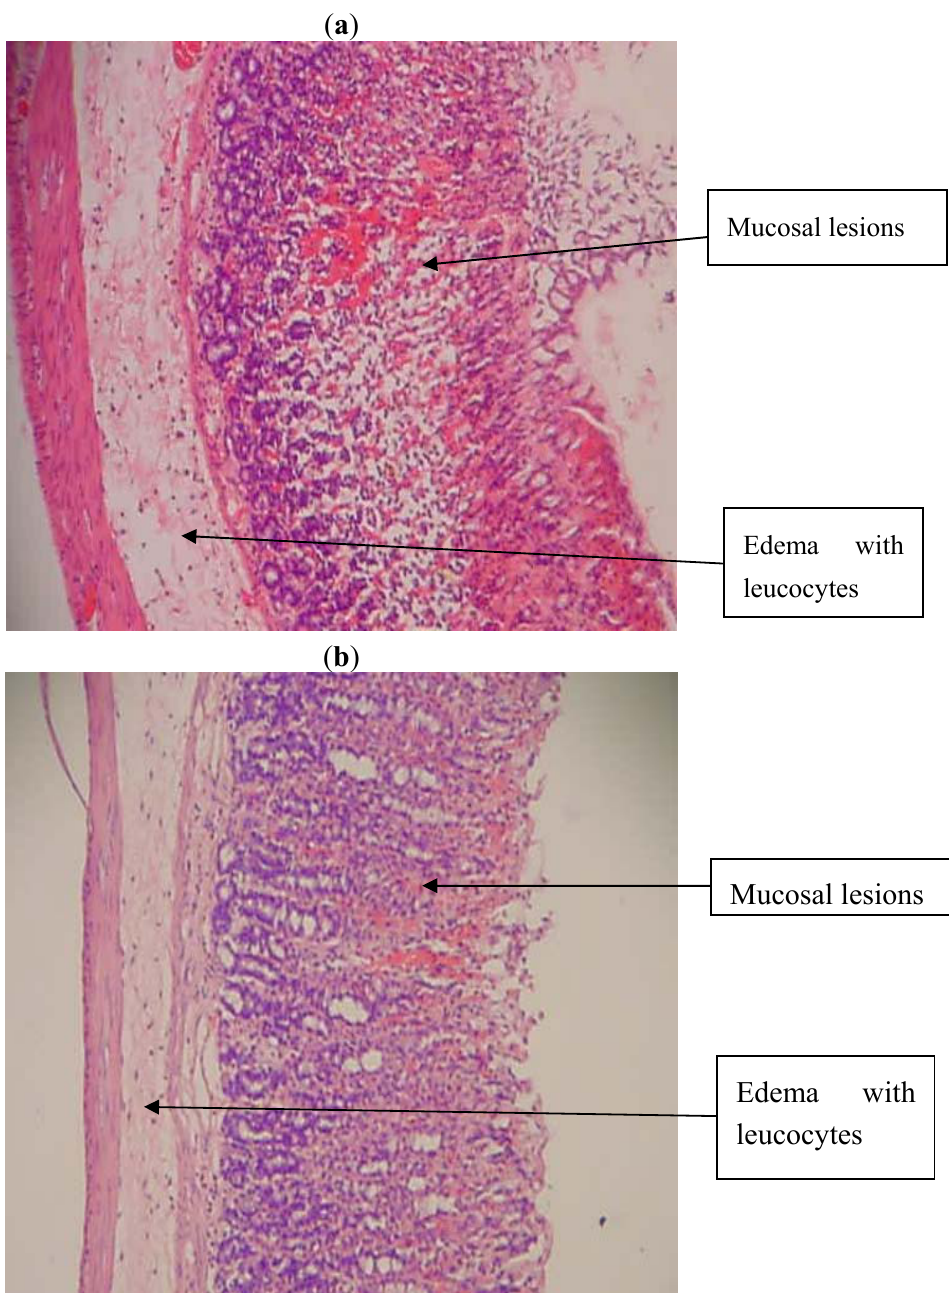
Edema with leucocytes